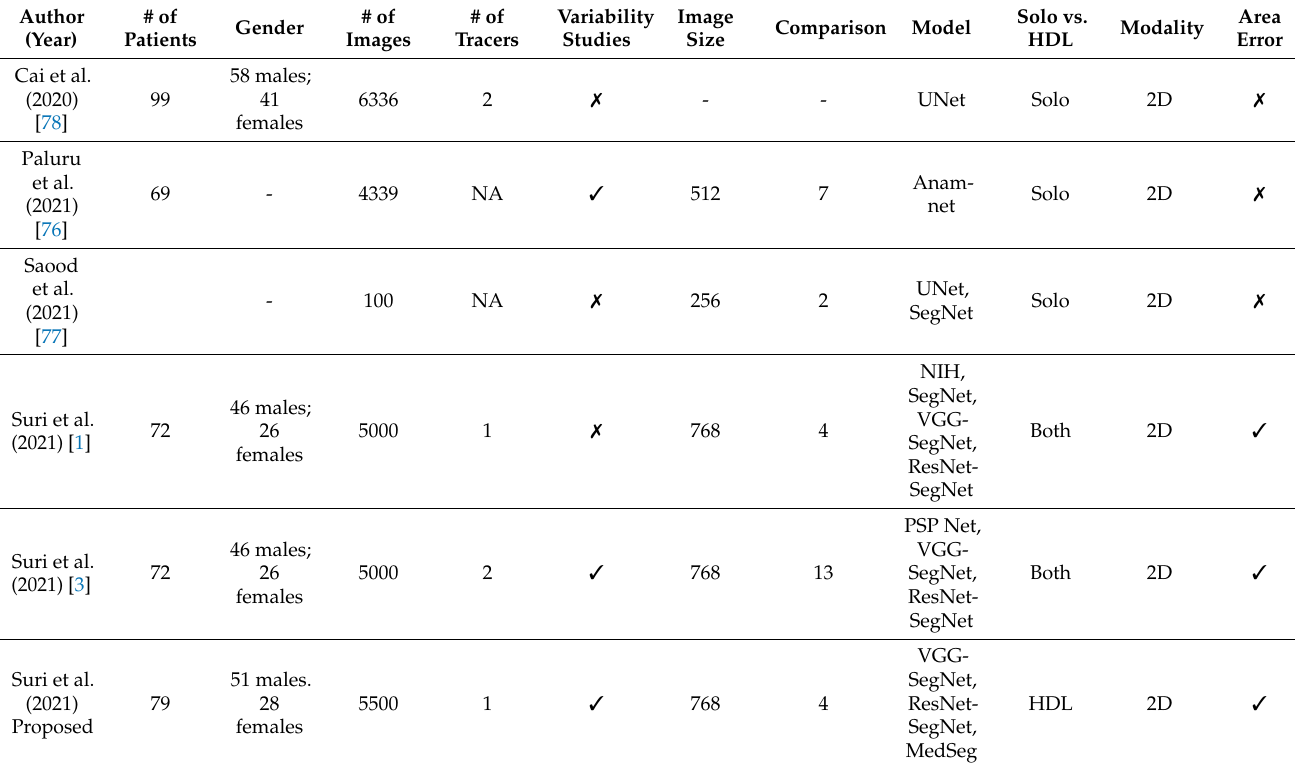
Table 3. Benchmarking